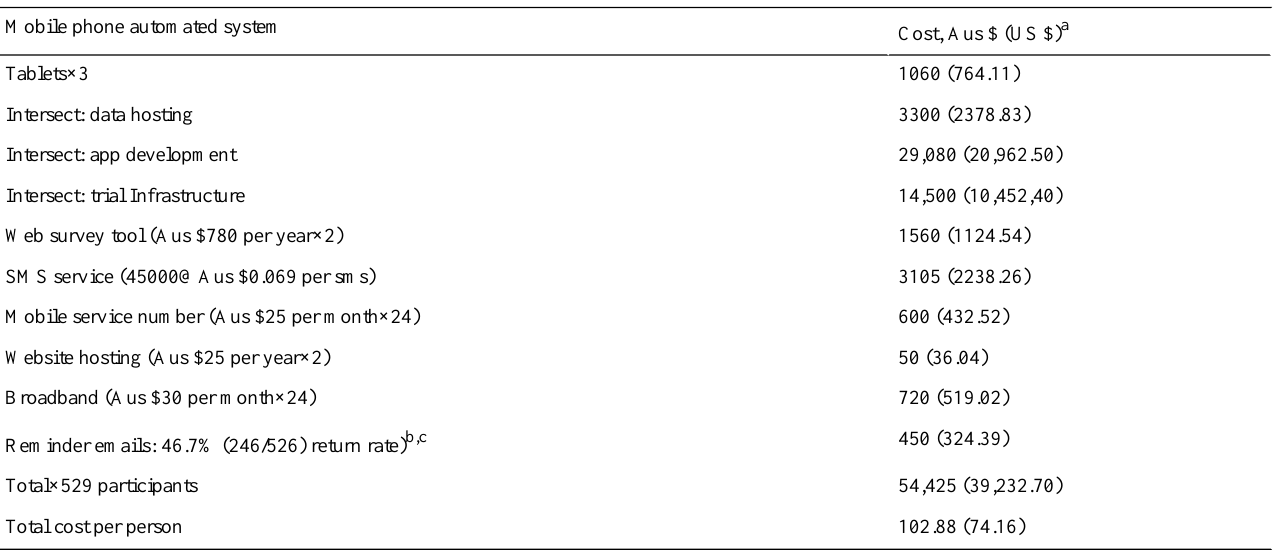
Table 5. Cost analysis for mobile phone automated